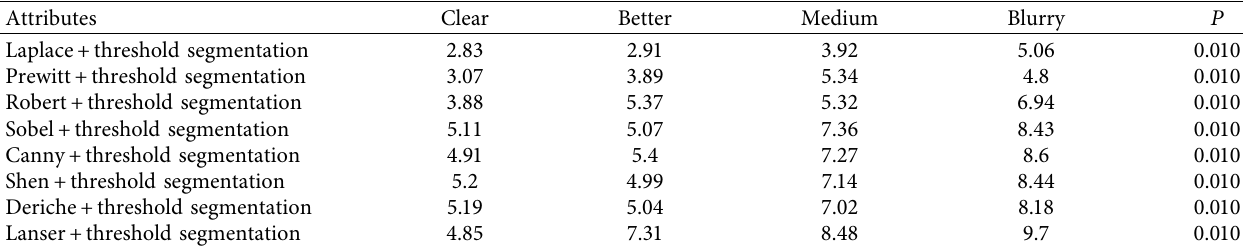
Table 4: Different edge detection operators perform global threshold segmentation data table.